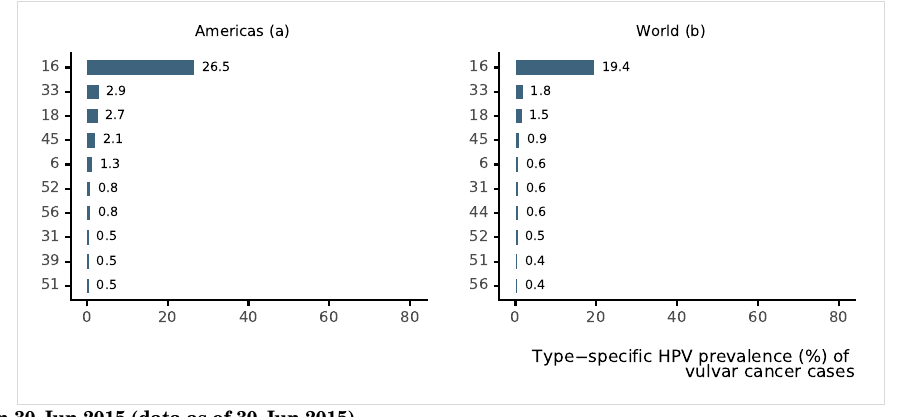
Figure 64: Comparison of the ten most frequent HPV types in cases of vulvar cancer in Americas and the World